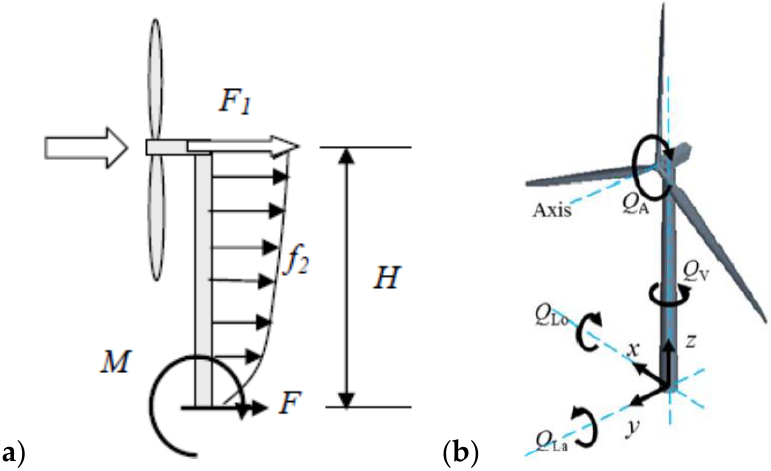
Figure A15. ( a ) Schematic of planar wind forces on a wind turbine [36]; ( b ) schematic of 3D wind load settings. Table A5. Comprehensive (3D) wind loads under the extreme condition.